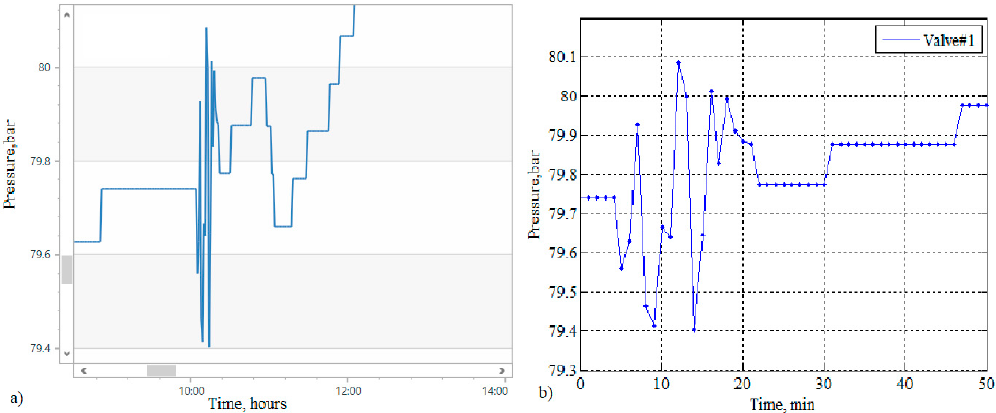
Figure 10. High-frequency fluctuations of regime parameters/chatter. Example 7 (valve 1): ( a ) a general view, ( b ) a detailed view.